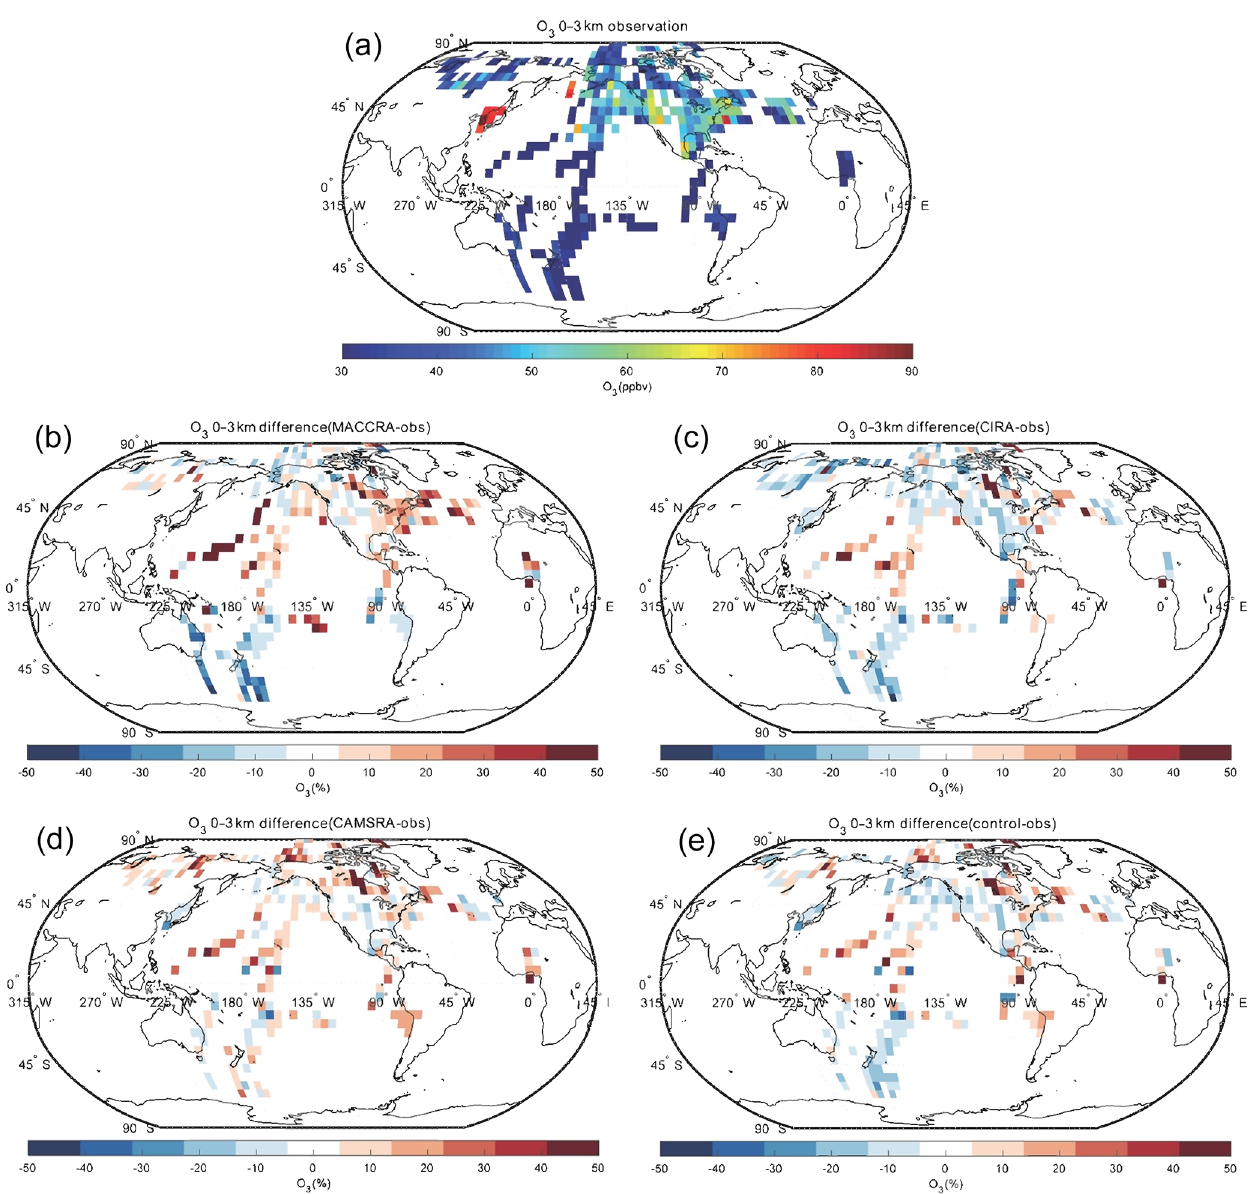
Figure 2. Campaign observations of O 3 (a) . (b) The relative difference in percent between MACCRA and the observations (MACCRA – observation). (c) The difference between CIRA and the observations (CIRA – observation). (d) The difference between CAMSRA and the observations (CAMSRA – observation), and (e) the difference between the control run and the observations (control – observation). The data are averaged to 5 ◦ × 5 ◦ (latitude × longitude) and to the altitude bin of 0–3km. Note that MACCRA only includes campaigns between 2003 and